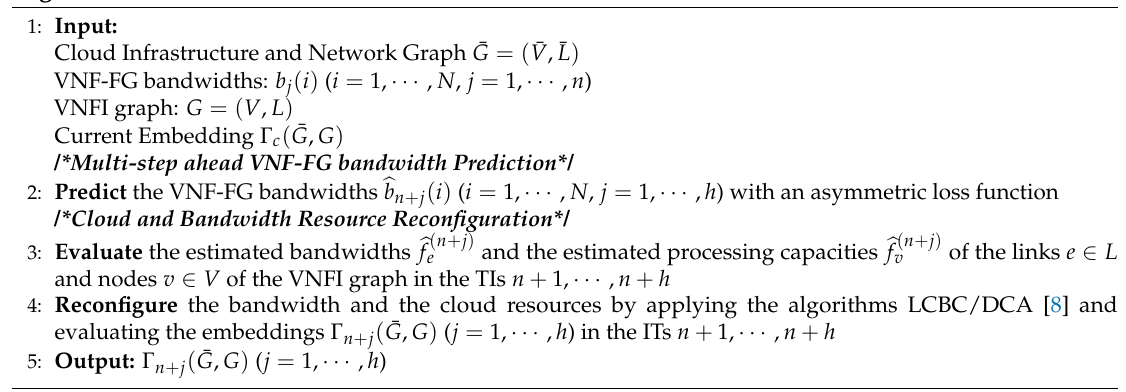
Algorithm 1 P REDICTION -B ASED NFV R ECONFIGURATION A